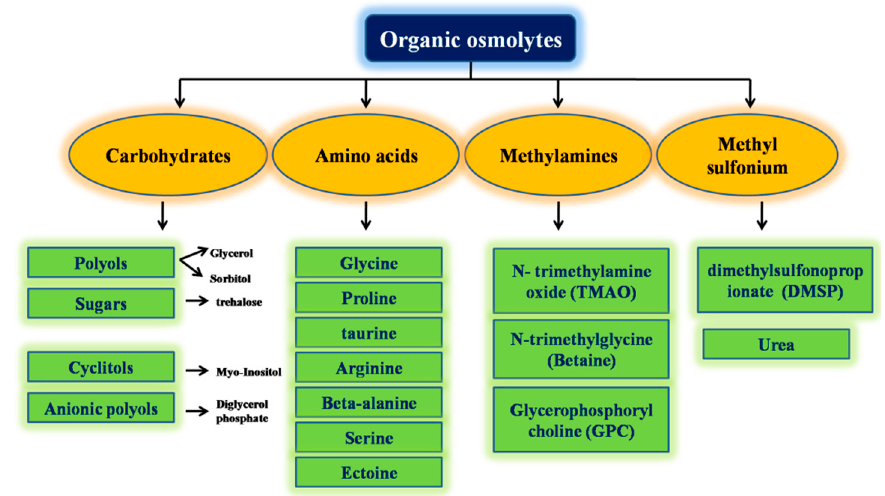
Figure 1. Classification of organic osmolytes.